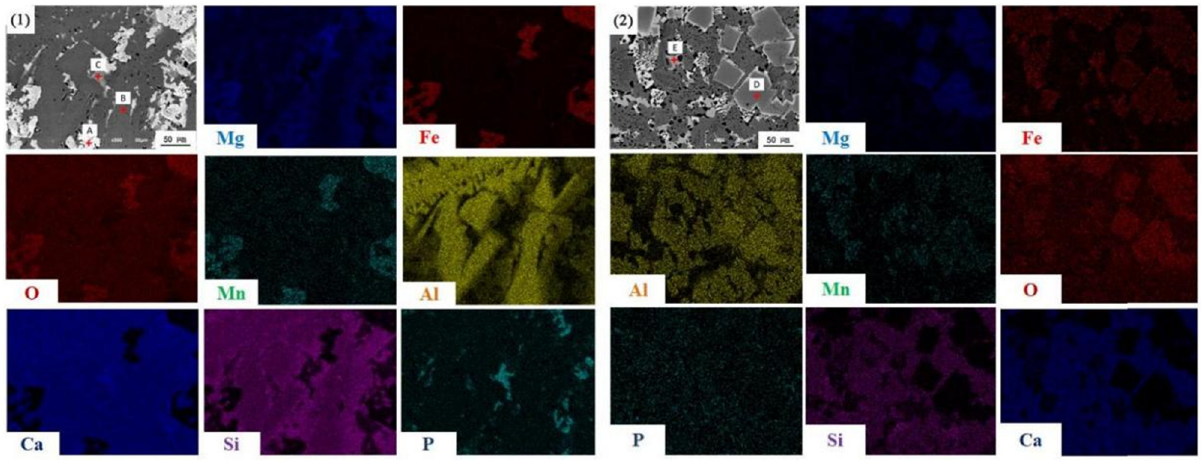
Figure 6: SEM scanning of mixed slag (( 1 ) R = 1.6; ( 2 ) R = 2.0; ( A ) MgFe 2 O 4 ; ( B ) Ca 2 Al 2 SiO 7 ; ( C ) Ca 2 SiO 4 - Ca 3 ( PO 4 ) 2 ; ( D ) MgFeAlO 4 ; ( E ) Ca ) . 2 Fe 2 O 5